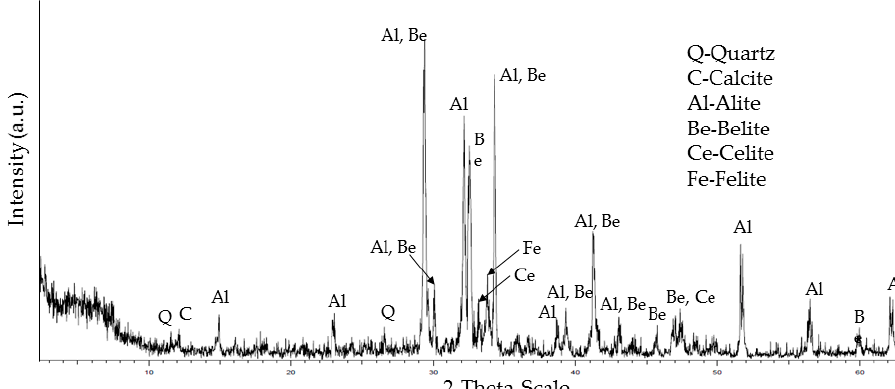
Figure 3. XRD mineral analysis of cement.